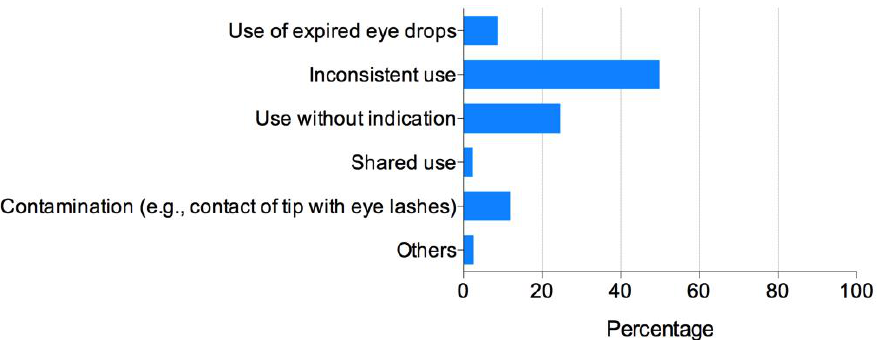
Figure 3. What is the most common misuse of antibiotic eye drops in your orthokeratology patients?